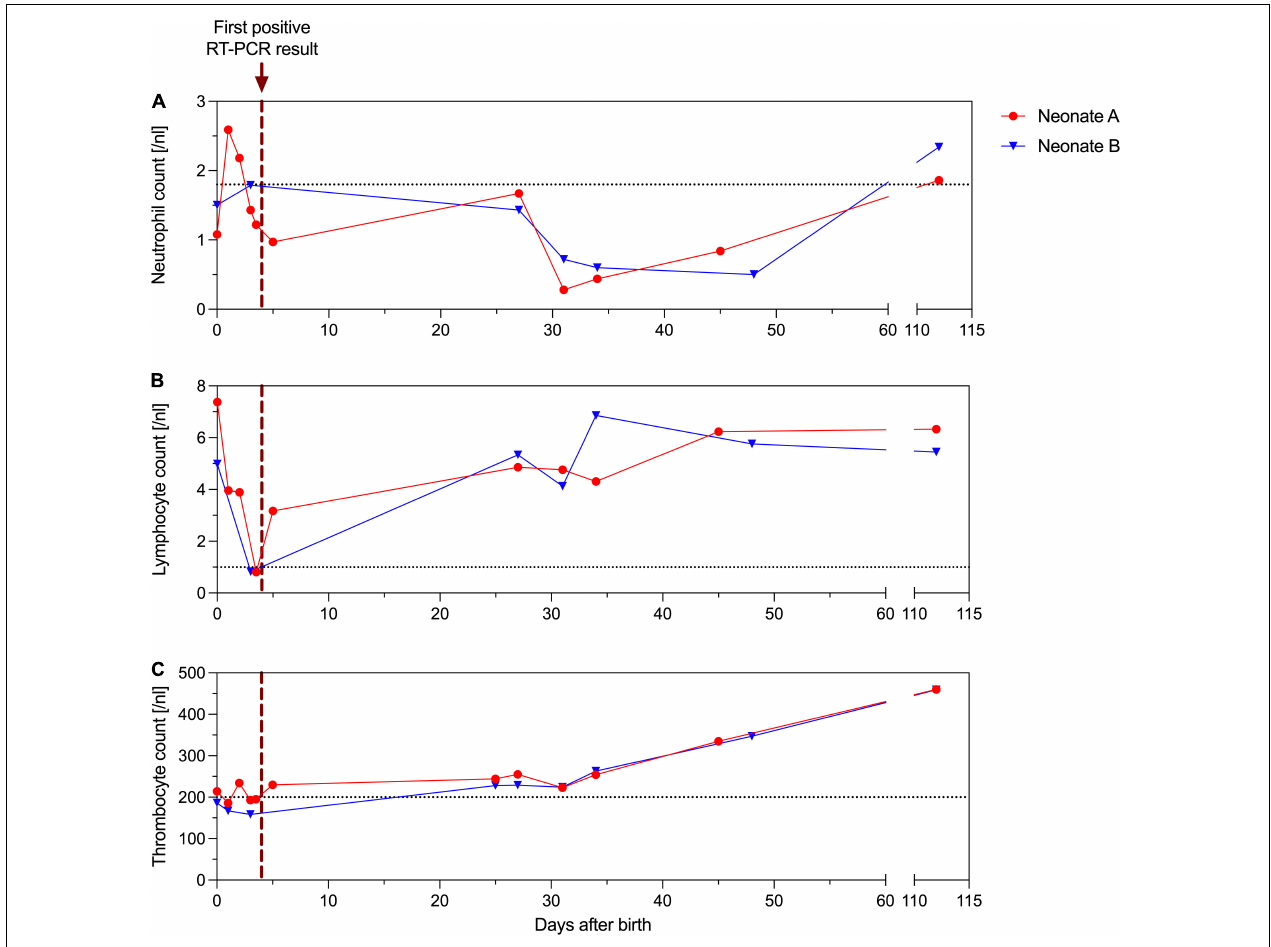
FIGURE 2 | Absolute neutrophil (A) , lymphocyte (B) and thrombocyte (C) counts [/nl] of neonate A (red) and B (blue). The purple dotted vertical line indicates the first positive RT-PCR result of the neonates’ nasopharyngeal swab. The gray dotted horizontal line indicates lowest range of the reference